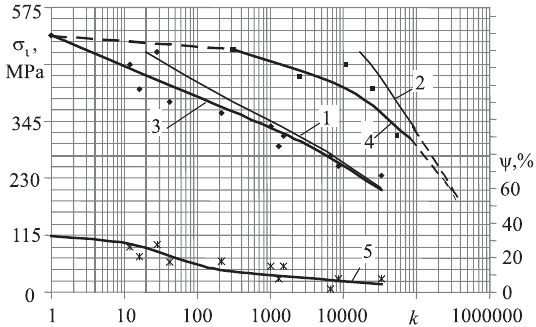
Fig. 5. Low cycle curves of steel 20GL (3, 4) and area reduction ( 5 ); ◆ – experimental points of a symmetric cycle ( R = –1); ■ – experimental points of a pulsating cycle ( R = 0), x – experimental points of area reduction. Th e theorethical